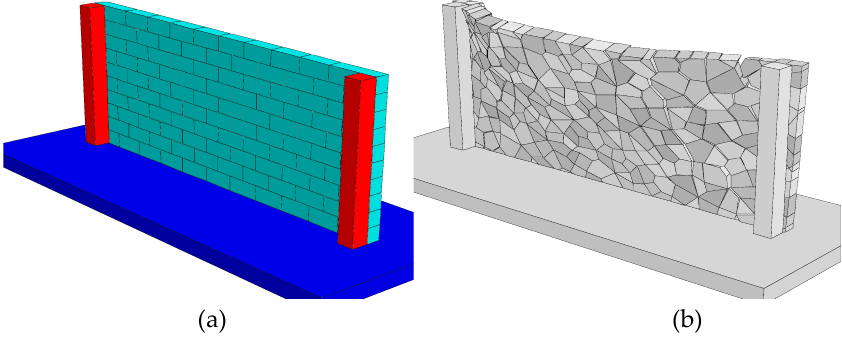
Figure 2. Masonry wall models. ( a ) Regular block pattern; ( b ) Voronoi block pattern, showing failure mode for out-of-plane loading.